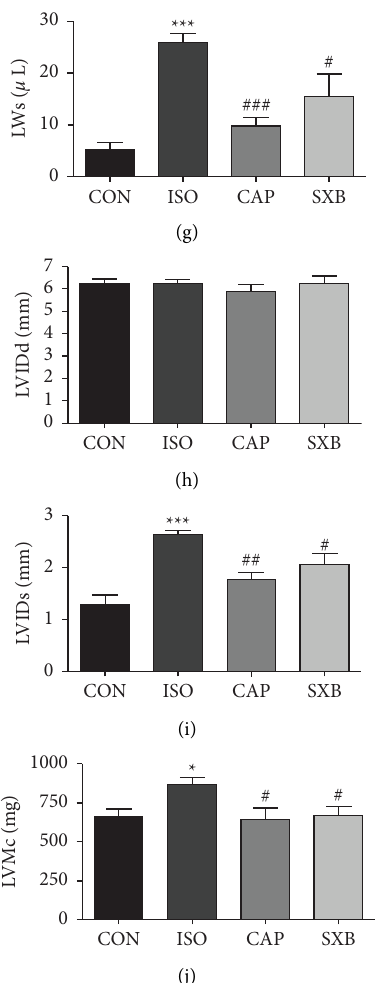
Figure 1: Echo data from the 4 groups. (a) Typical echo screenshots of three consecutive cycles. (b) HR (c) LVPWd (d) LVAWd (e) FS (f) EF (g) LVVs (h) LVIDd (i) LVIDs (j) LVMc were measured among the CON ( n � 13), ISO ( n � 13), CAP ( n � 7), and SXB groups ( n � 9). ∗ P